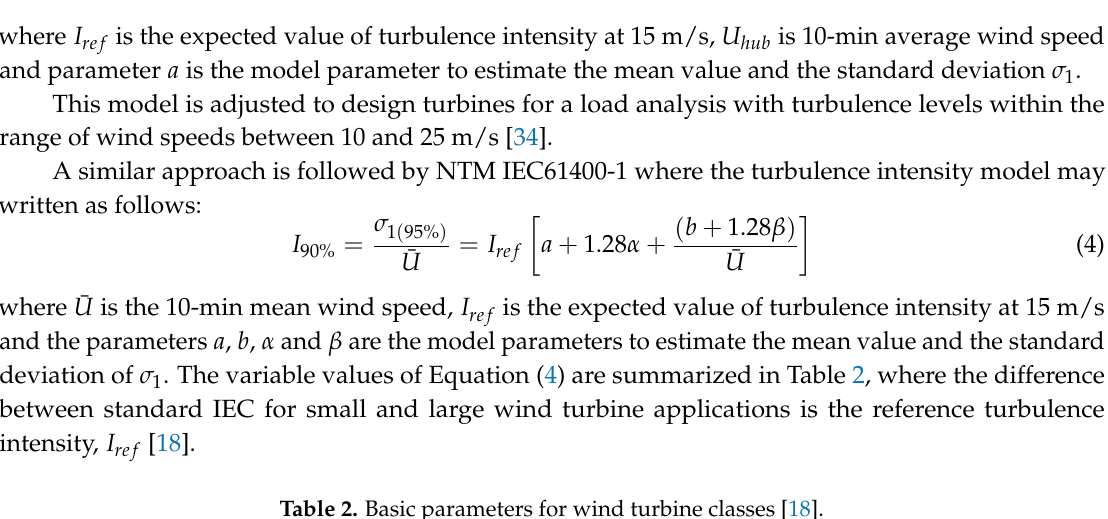
Table 2. Basic parameters for wind turbine classes